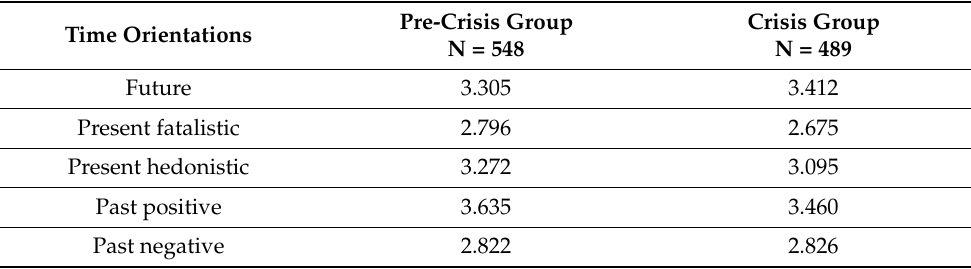
Table A1. Mean values for time orientations in the pre-crisis and crisis groups in the western region.